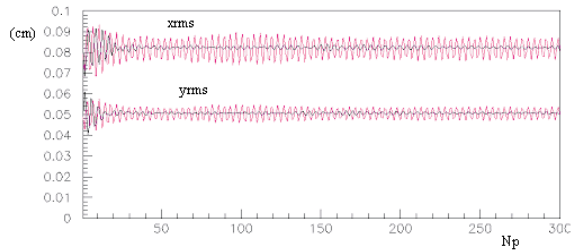
FIG. 6. (Color) Beam betatron spectrum with initial Gaussian distribution for the case s (cid:5) s 0 (cid:2) 0.83 (corresponding to I (cid:2) 24 mA). The odd mode half frequency, v o , is 50 MHz and the even mode half frequency, v e , is 53 MHz. Npt is the particle number.